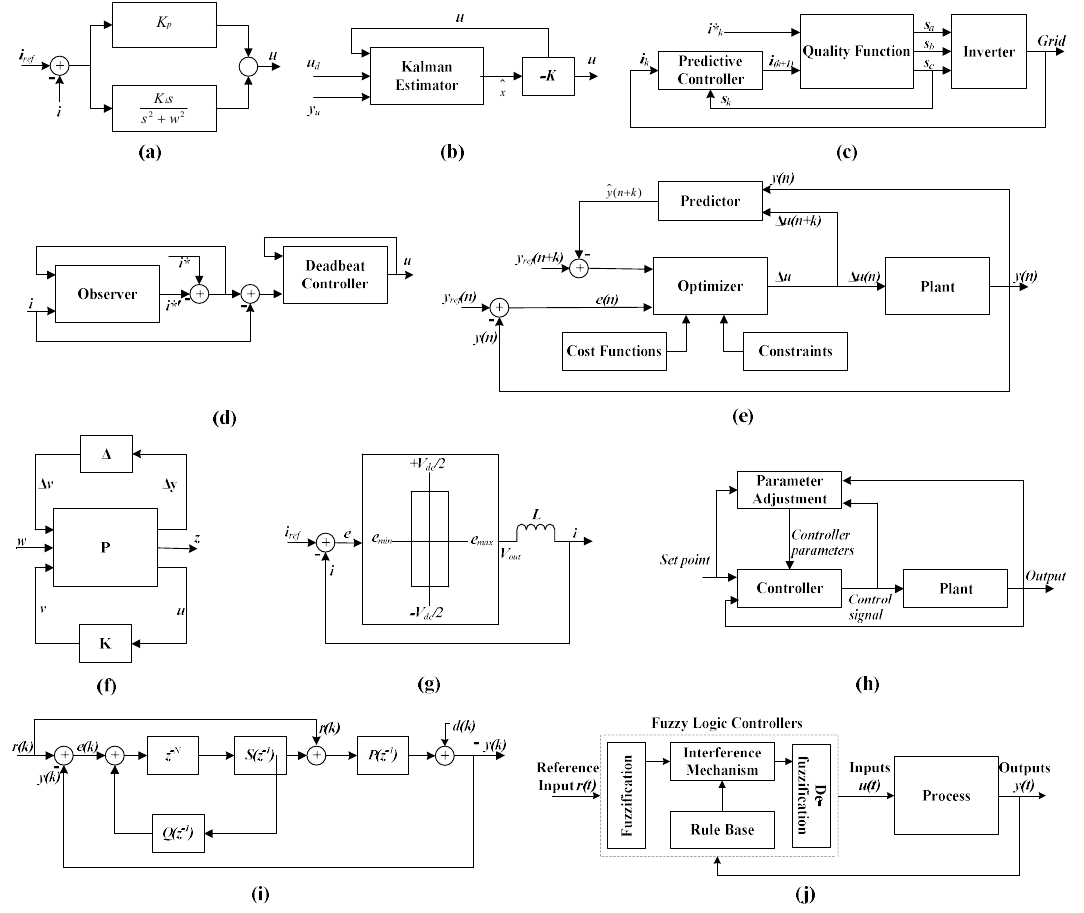
Figure 11. Block diagram of controllers ( a ) proportional resonant (PR) [145]; ( b ) linear quadratic gaussian (LQG) [146]; ( c ) predictive controllers (PC) [147]; ( d ) deadbeat controllers [22]; ( e ) MPC [149]; ( f ) robust controllers [153]; ( g ) hysteresis controllers HC [173], ( h ) adaptive controllers [175], ( i ) repetitive controllers (RC) [184]; and ( j ) fuzzy logic controllers (FLC) [186].